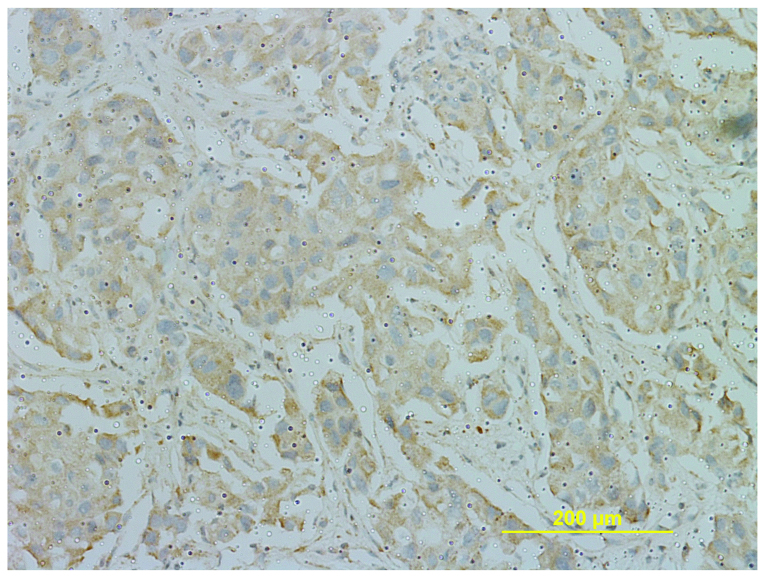
Representative image of immunohistochemical analysis of HIF-1α expression in cholangiocarcinoma samples. Positive staining for HIF-1α (brown) in choloangiocarcinoma cells (scale bar, 200 µm). HIF, hypoxia-inducible factor.